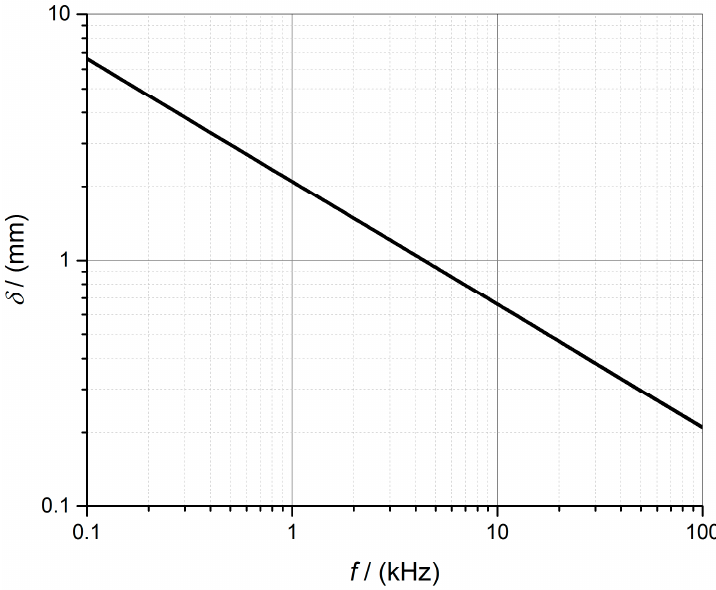
Figure 6. Penetration depth of copper wire with current frequency.